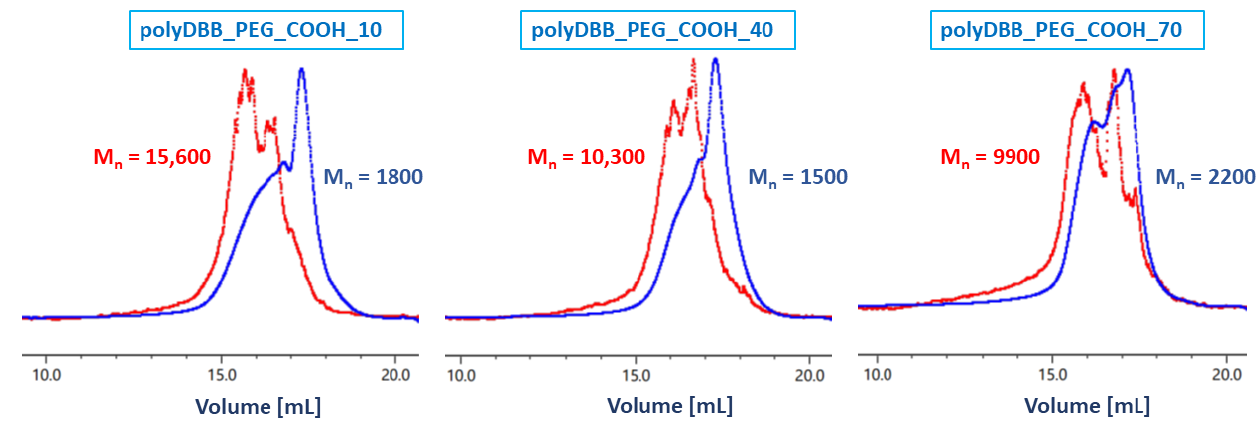
Figure 7. Comparison of chromatograms for copolymers containing 10, 40 and 70 wt % of PEG_COOH obtained from GPC (blue curve) and MALS (red curve).